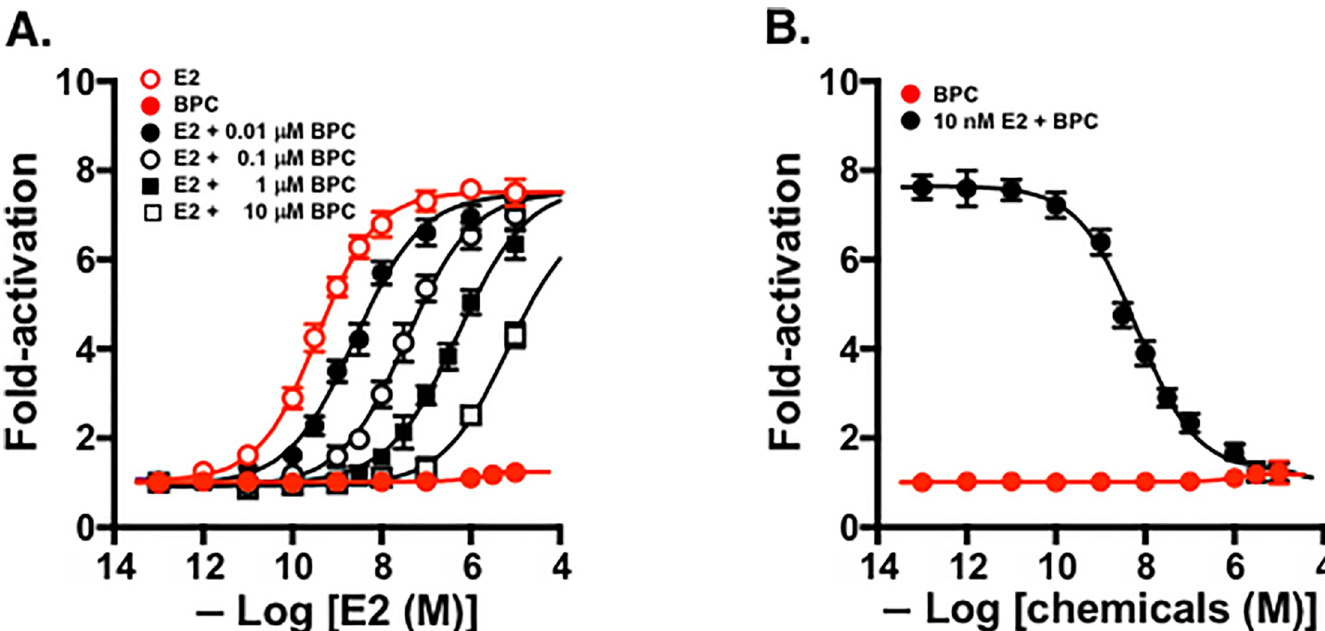
Fig 4. Luciferase reporter gene transcription inhibition assays for ER β . The dose-response curves are shown for ( A ) the residual activity of 10 nM E2 for ER β in the presence of serial concentrations of BPC, and ( B ) E2 from the assays for ER β in the presence of serial concentrations of BPC.